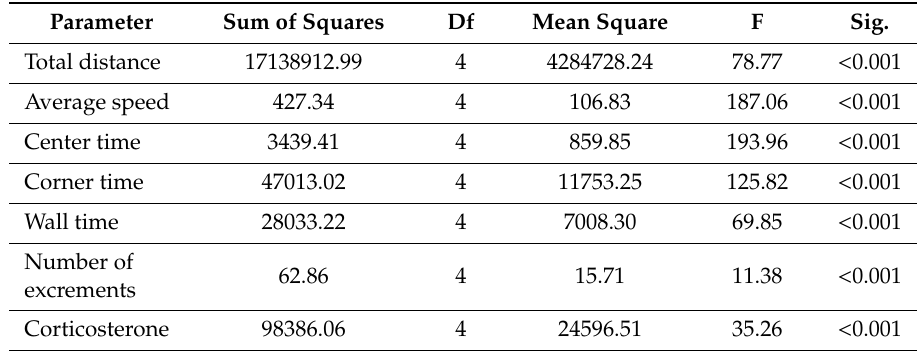
Table 3. ANOVA findings for the five groups of the